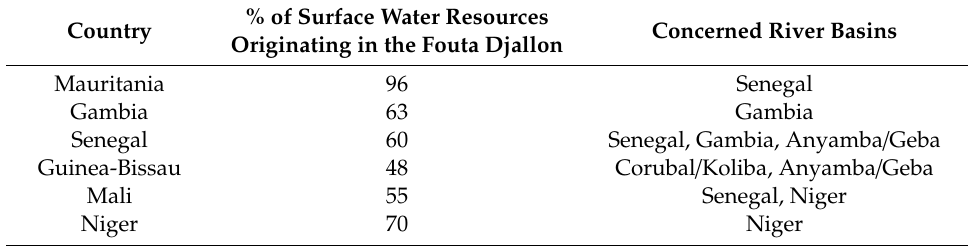
Table 1. Dependence rate (%) from water coming of the Fouta Djallon highlands of the concerned West African countries [5].